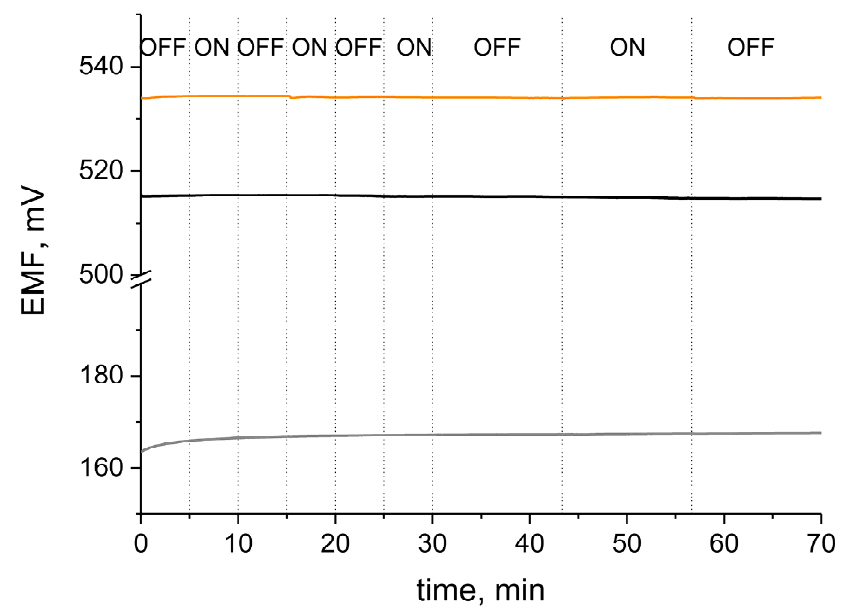
Figure 6. Potentiometric response recorded for GCD/K + -ISM (grey line), GCD/hCeO 2 + NTs/K + -ISM (black line) and GCD/hCeO 2 + POT/K + -ISM (orange line) electrode during the light test (with light ON and OFF).